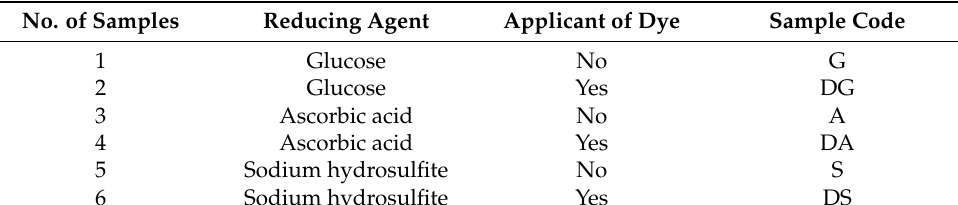
Table 2. Design of experiment for the developed samples.